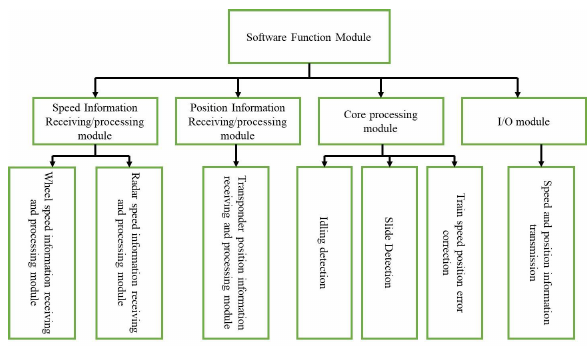
(2) Idling/taxiing detection and wheel